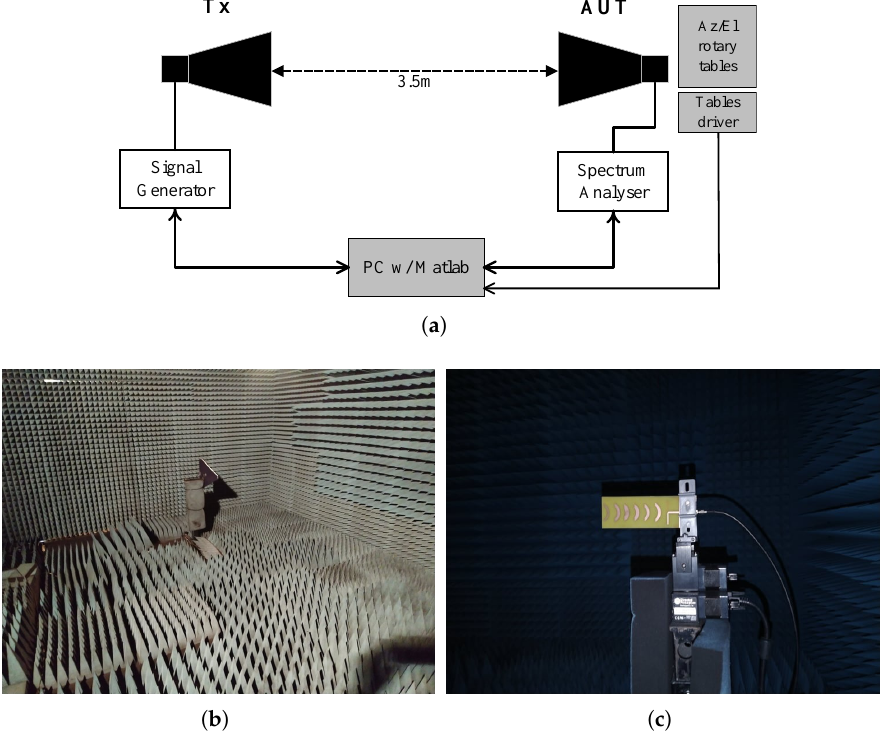
Figure 8. Radiation pattern measurement setup: ( a ) block diagram; ( b ) photography of Tx antenna and ( c ) close up an AUT, inside the anechoic